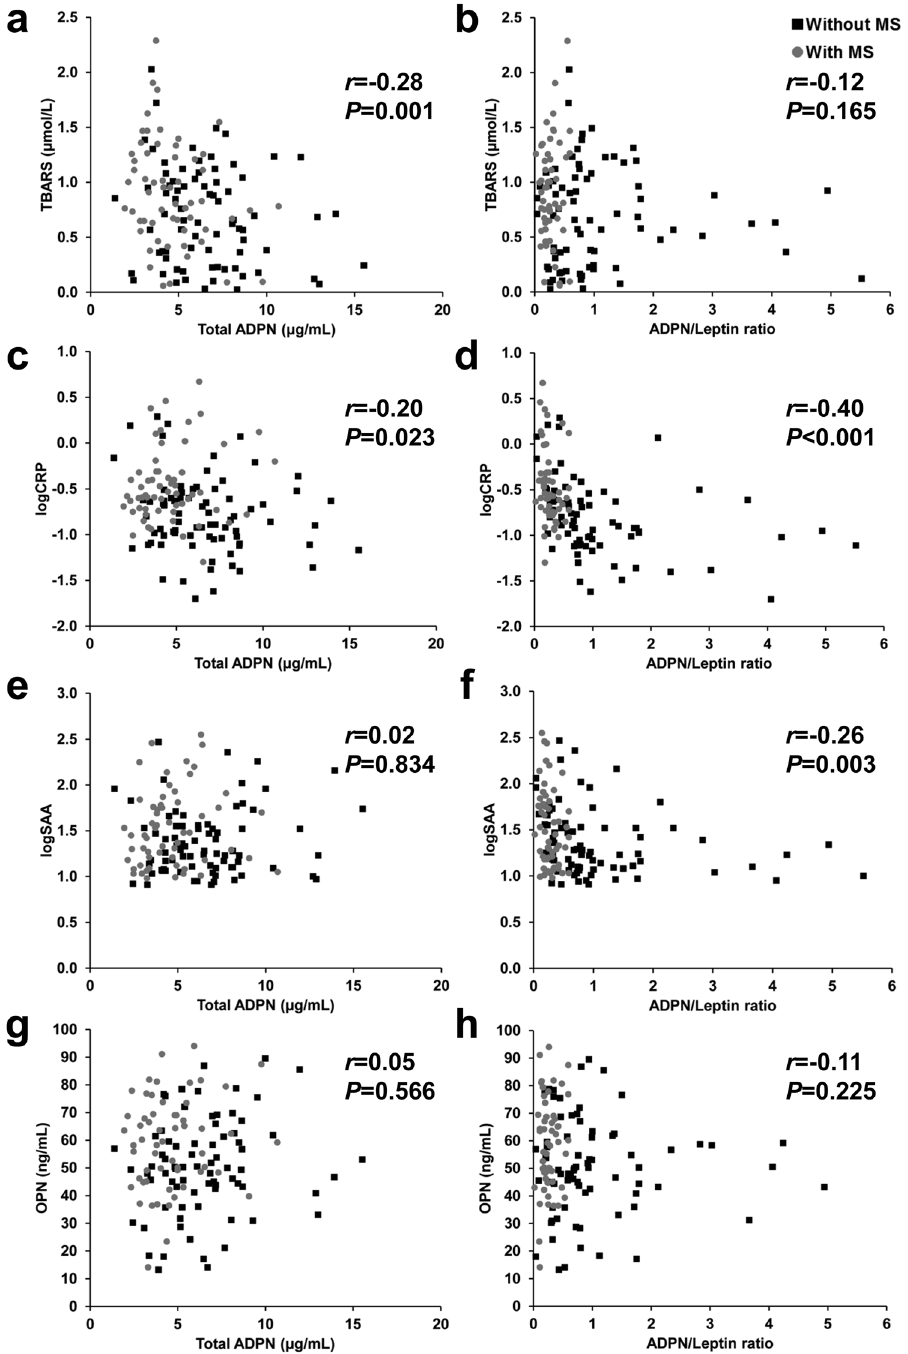
Figure 2. Scatter diagrams showing the correlations between the circulating concentrations of total adiponectin and the ADPN/leptin ratio with the levels of TBARS ( a and b ), CRP ( c and d ), SAA ( e and f ) and osteopontin (OPN) ( g and h ). Pearson’s correlation coefficient and P values are indicated. CRP and SAA were logarithmically transformed due to non-normal